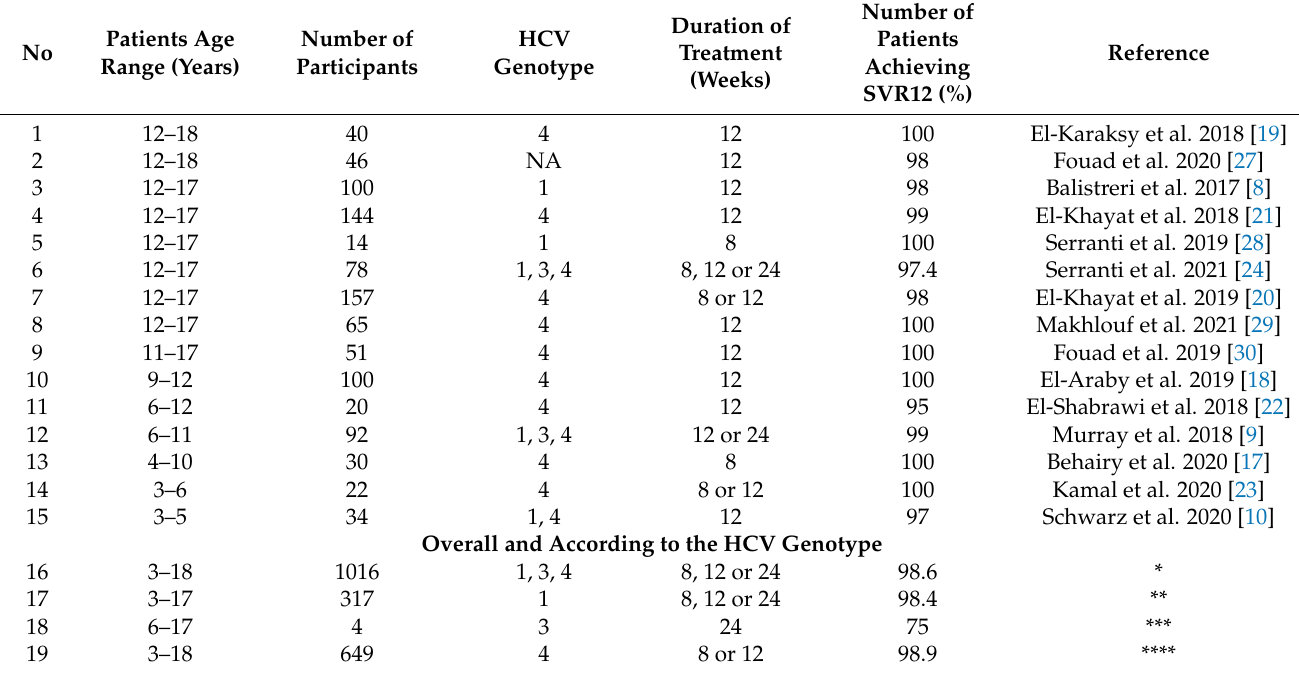
Table 4. Summary of the studies on LDV/SOF efficacy in pediatric patients with chronic hepatitis